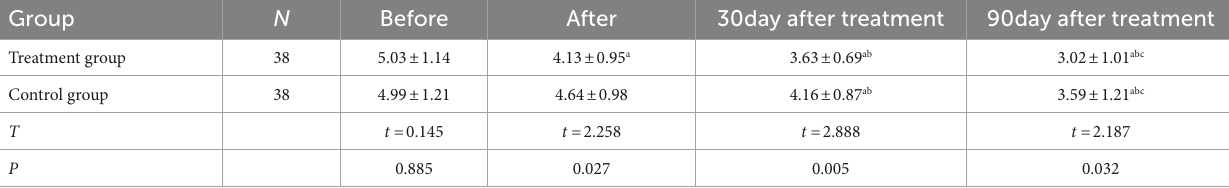
TABLE 4 The data before and after the TMS treatment of the different studied variables (NRS2002). Group N Before After 30 day after treatment 90 day after treatment